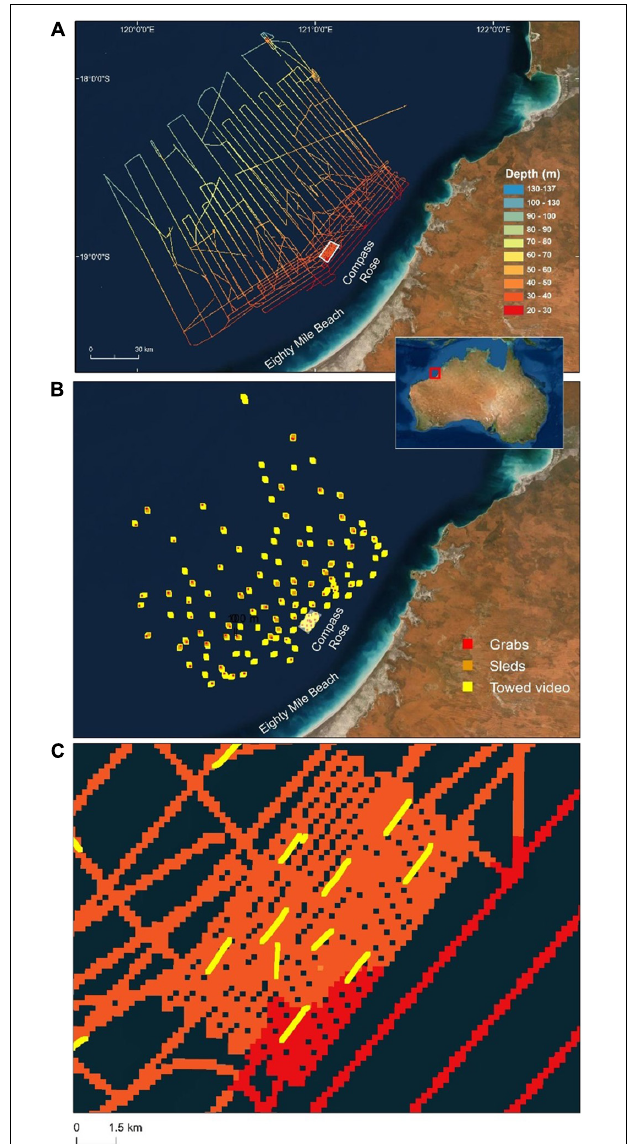
FIGURE 1 | Study area offshore from Eighty Mile Beach showing (A) ships track shaded by depth (from multibeam sonar), (B) locations of all sampling by towed video ( n = 119), benthic sled ( n = 35) and sediment grab ( n = 85), and (C) close-up view of the Compass Rose area with depth (colour shading) and towed video tracks (yellow lines). Basemaps sourced from ESRI, DigitalGlobe, GeoEye, Earthstar Geographics, CNES/Airbus DS, USDA, USGS, AeroGRID, IGN and the GIS User